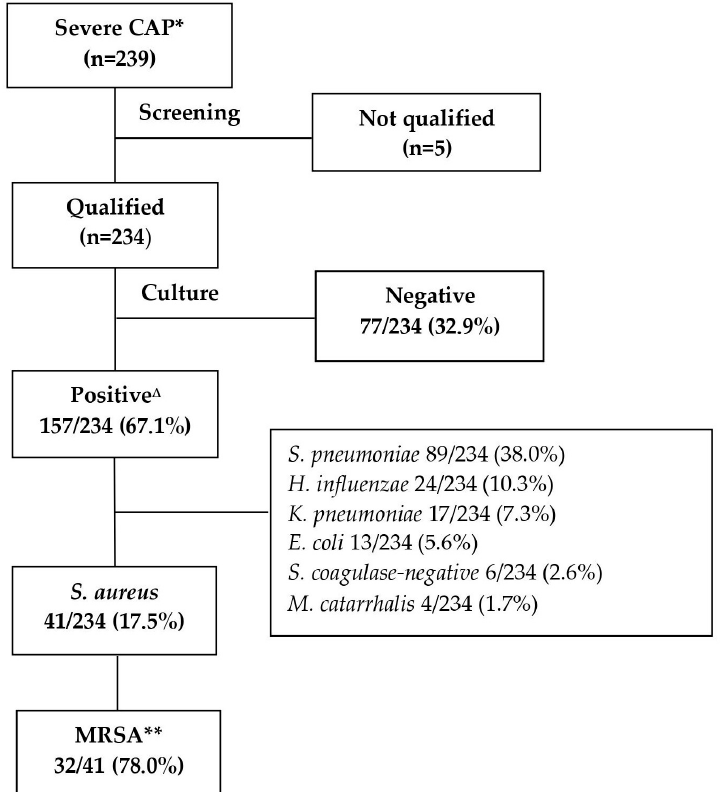
Figure 2. Research flowchart. * CAP: community-acquired pneumonia; ** MRSA: Methicillin-resistant Staphylococcus aureus ; ∆ : Among the 157 positive cases, there were 37 co-infections with microorganisms, including 14 co-infections with S. pneumoniae and H. influenzae , 7 co-infections with S. pneumoniae and S. aureus , 5 co-infections with S. pneumoniae and K. pneumoniae , 4 co-infections with S. aureus and K. pneumoniae , 2 co-infections with S. pneumoniae and S. coagulase-negative , 2 co-infections with S. pneumoniae and E. coli , 2 co-infections with K. pneumoniae and H. influenzae , and 1 co-infection with S. aureus and E. coli .